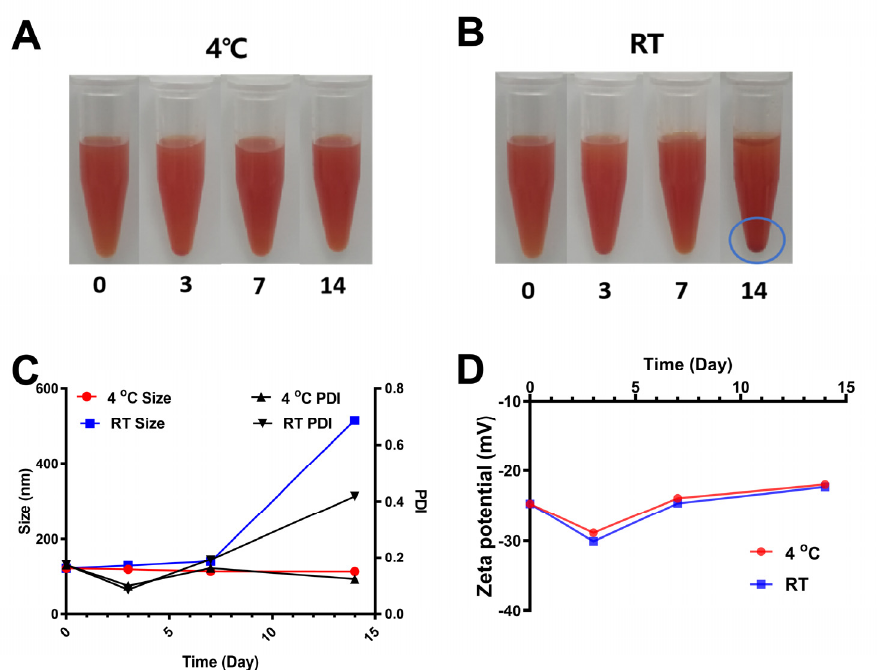
Figure 7. Stability of SCP-Se NPs at different storage temperatures. ( A ) Appearance changes of SCP-Se NPs colloidal solution at 4 ◦ C. ( B ) Appearance changes of SCP-Se NPs colloidal solution at room temperature (RT). ( C ) Changes in particle size and PDI of SCP-Se NPs at 4 ◦ C and RT. ( D ) Changes of Zeta potential of SCP-Se NPs at 4 ◦ C and RT.